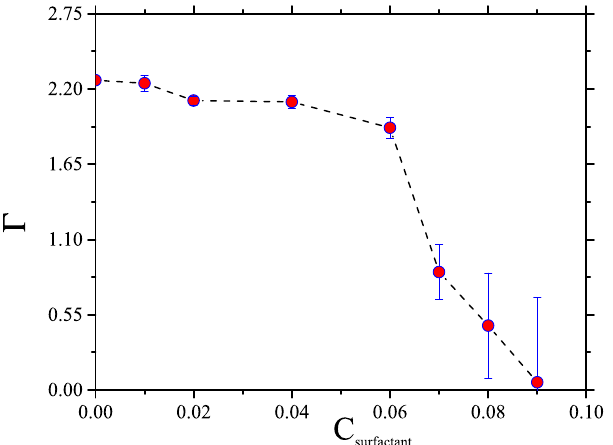
Figure 3. Desorption isotherm (Г) for a mixture of four types of HC (butane, heptane, decane and dodecane, with molecules of each in the cell) by means of the addition of long nonionic surfactants, see right image in Fig. 1F, as a function of surfactant concentration (C surfactant ). The line is only a guide for the eye; all quantities are reported in reduced DPD units.